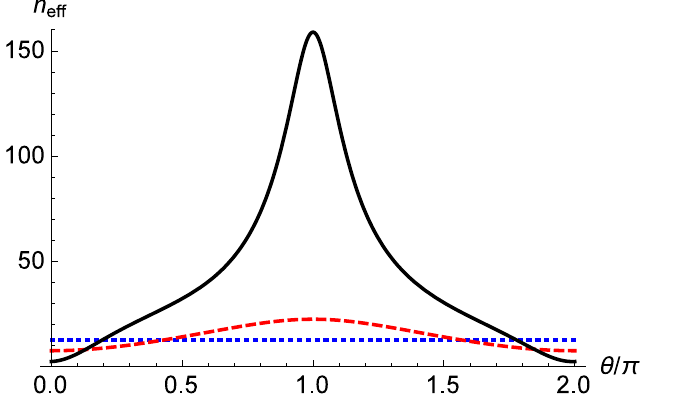
Figure 3. Plot of the effective mean vibrational number n ef f in the movable mirror as a function of the parametric phase θ / π for different parametric gains G = 0 (blue dotted), 0.05 κ (red dashed), and 0.18 κ (black solid) when the input laser power ℘ is 0.1 mW.